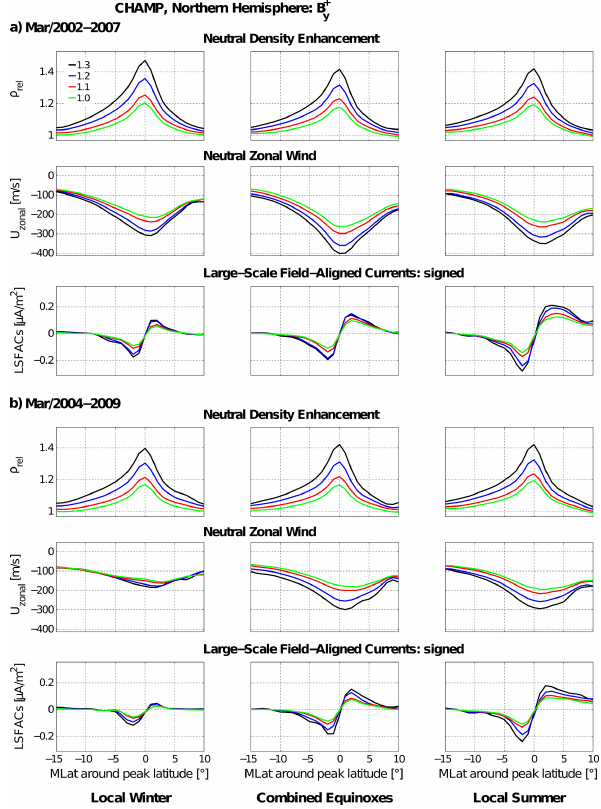
Fig. 4. The superposed epoch analysis curves of (from top to bot- tom) ρ rel , U zonal , and LSFACs (signed) for IMF B + y in the North- ern Hemisphere for two periods: (a) March 2002–March 2007 and (b) March 2004–March 2009. The results are shown for ρ thr 1.1, 1.2, and 1.3 and for three local seasons: (from left to right) local winter, combined equinoxes, and local